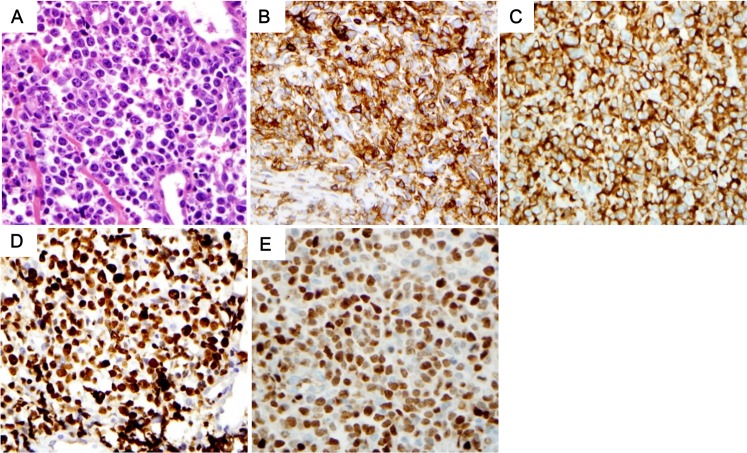
Pathologic characteristics of CD5+ DLBCL.Pleomorphic large cells with many apoptotic features were shown in many cases (A). Tumor cells were positive for CD5 (B), BCL2 (C), IRF4/MUM1 (D). Note the diffuse strong pattern in CD5 IHC. Tumor cells also showed high Ki-67 proliferation index (E).